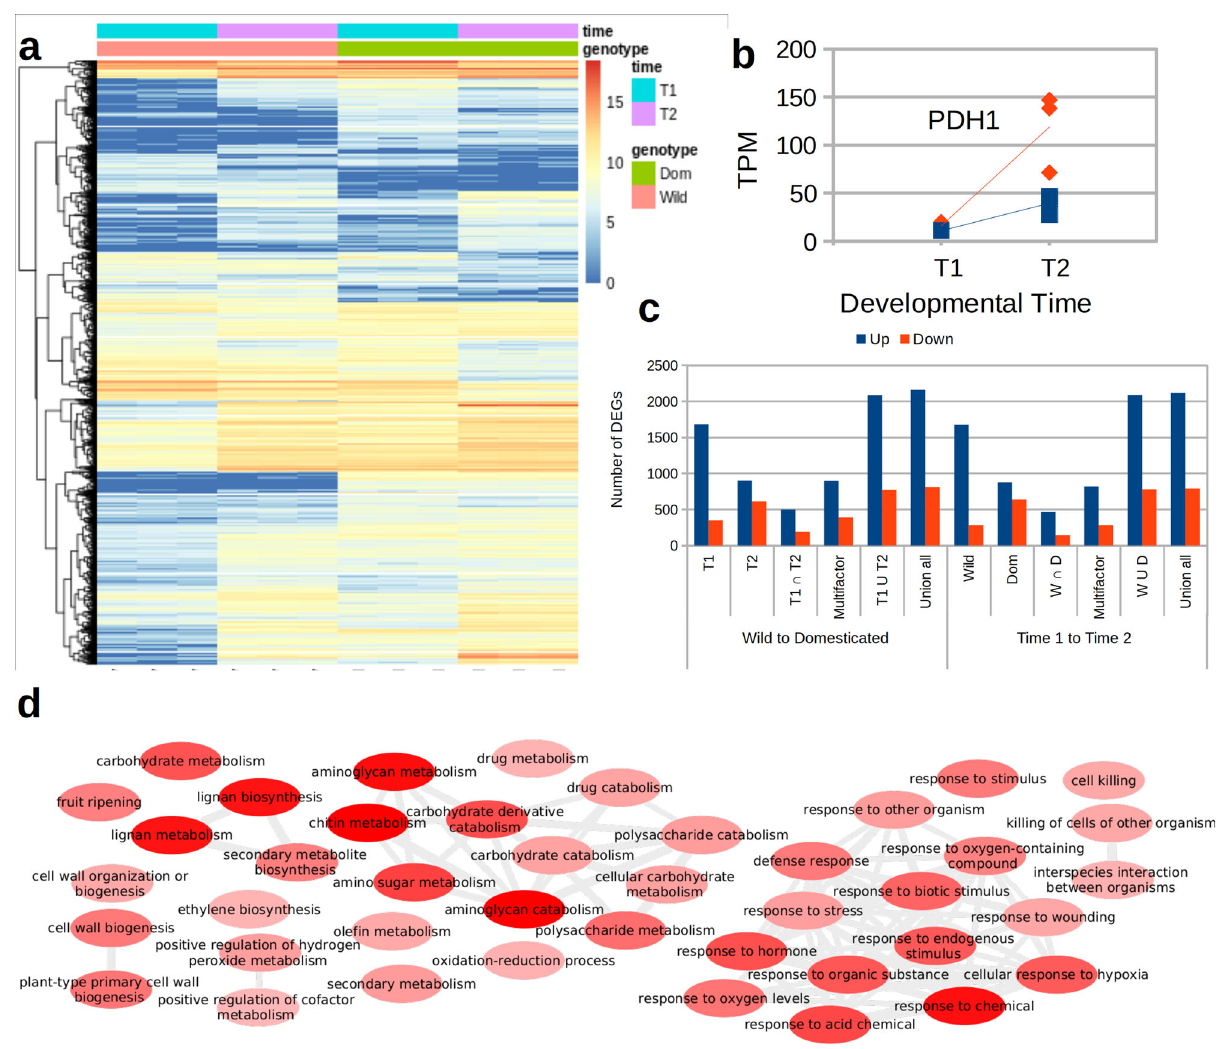
Fig. 4 Gene expression at pod developmental stages T1 and T2. a Heatmap of normalized expression values within genes with differential expression. The left dendrogram corresponds to an unsupervised hierarchical clustering of the genes based on the normalized expression values. b Expression trajectories of the gene PlPDH1 in the domesticated accession (blue) and the wild accession (red) across two developmental times. TPM, transcripts per million. c Number of genes with differential expression (DEGs) between one wild and one domesticated accession and between two developmental times. d Concept map of functional categories enriched for genes more expressed in the second developmental time only in the wild accession. Source data are provided as a Source Data fi